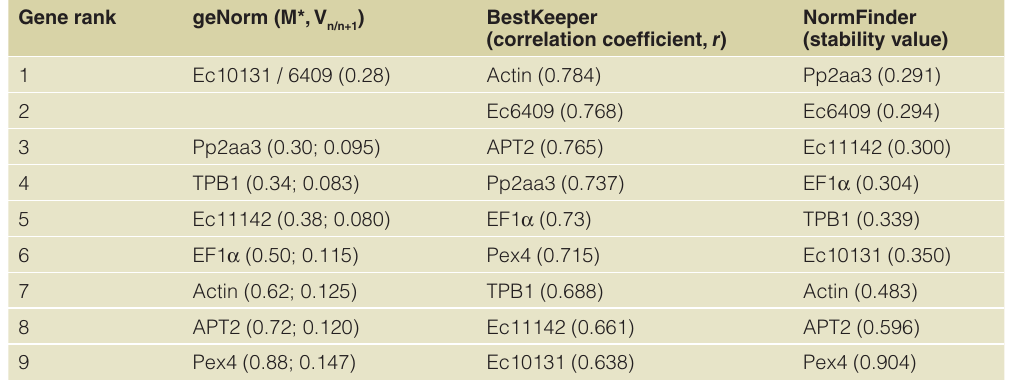
Table 2. Ranking of Erythroxylum coca reference gene stability in all Erythroxylum coca tissues according to the geNorm, BestKeeper and NormFinder